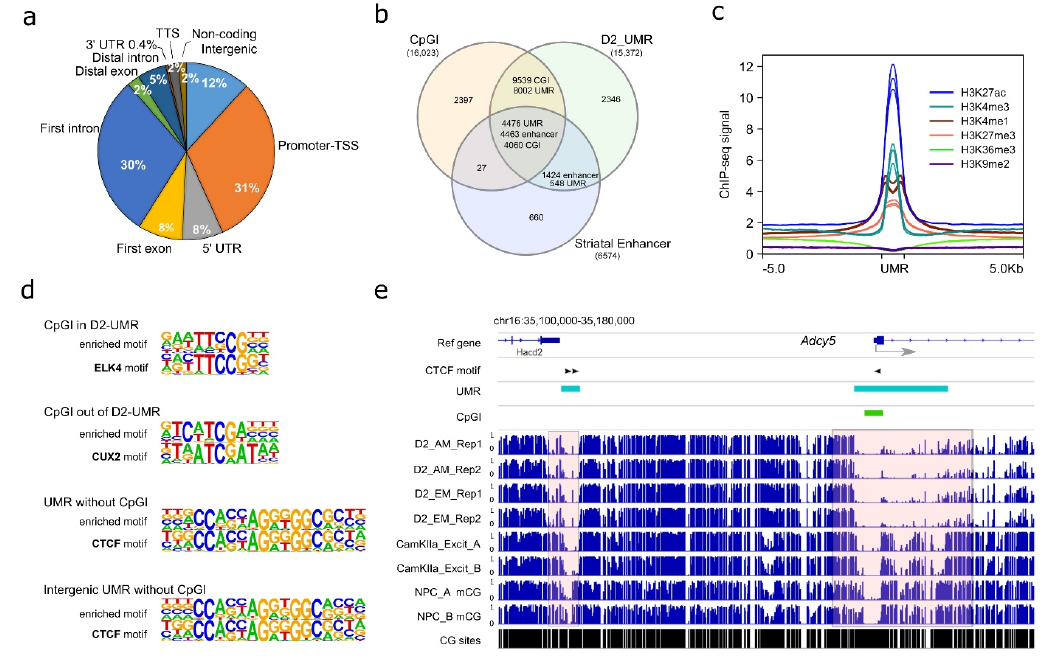
Figure 3. Characterization of NAc D2-MSN UMRs. ( a ) Genomic feature distribution of NAc D2-MSN UMRs. They are mostly located in TSS-proximal regions, including “Promoter-TSS”, “5’-UTR”, “First exon”, and “First intron”. ( b ) D2-MSN UMRs significantly overlap with CGIs and striatal enhancers. ( c ) Histone modification enrichments at D2-MSN UMRs. H3K4me1, H3K4me3, H3K27ac, H3K27me3, H3K9me2, H3K36me3 Chromatin IP signals are presented along up- and down-stream 5 kb regions of UMR sites. RPKM normalization is performed across all histone ChIP-seq data. ( d ) The top enriched motif sequence and matched transcription factor in each of the four categories of CGI/UMR regions. CGI in D2-UMR: CpG islands located in D2-MSN UMRs; CGI out of D2-UMR: CpG islands located outside of D2-MSN UMRs; UMR without CGI: D2-MSN UMRs that do not have a CpG island inside; intergenic UMR without CGI: intergenic D2-MSN UMRs that do not have a CpG island inside. ( e ) Adcy5 locus with two neighboring D2-MSN UMRs. The proximal UMR overlaps with a CGI and the distal UMR does not. The two shaded areas highlight regions with cell type-specific differential methylation. D2: D2-MSNs. CamKIIa_Excit: PFC CamKIIa+ excitatory neurons. NPC: neural progenitor cells. AM: AM-seq. EM: EM-seq. CG sites lane shows the CpG frequency. Black arrowhead indicates a CTCF motif in UMR regions.